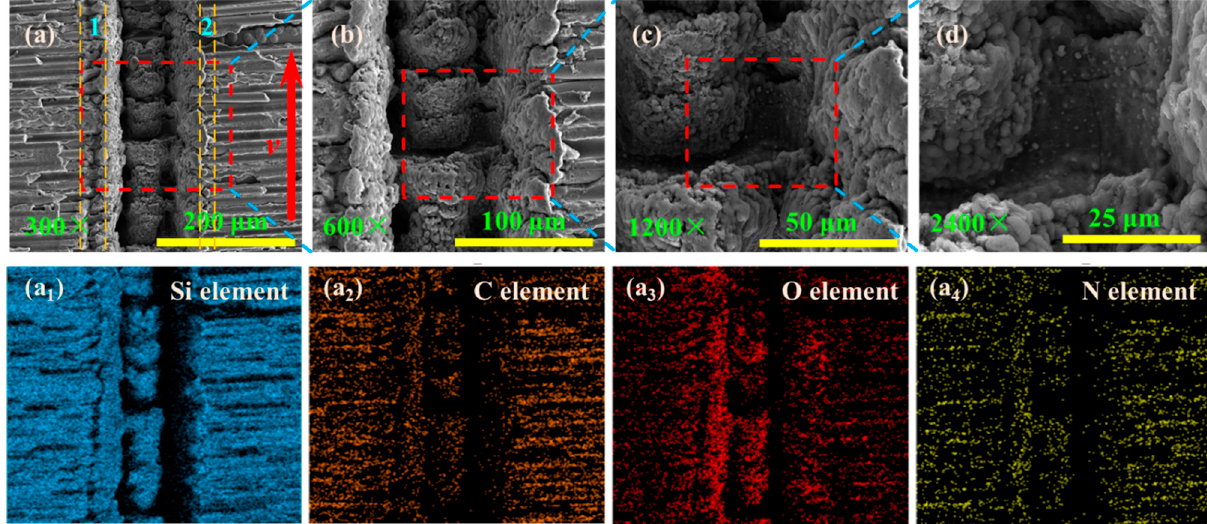
Figure 13. The grooved morphologies corresponding to different magnifications and distribution of different elements of fiber transverse arrangement ( a 1 – a 4 ) and laser longitudinal scanning region: ( a ) 300 × magnifications; ( b ) 600 × magnifications; ( c ) 1200 × magnifications; ( d ) 2400 × magnifications.